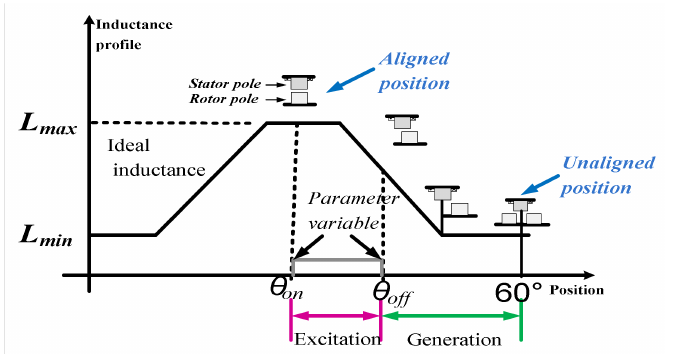
Figure 1. Inductance curve versus rotor position.